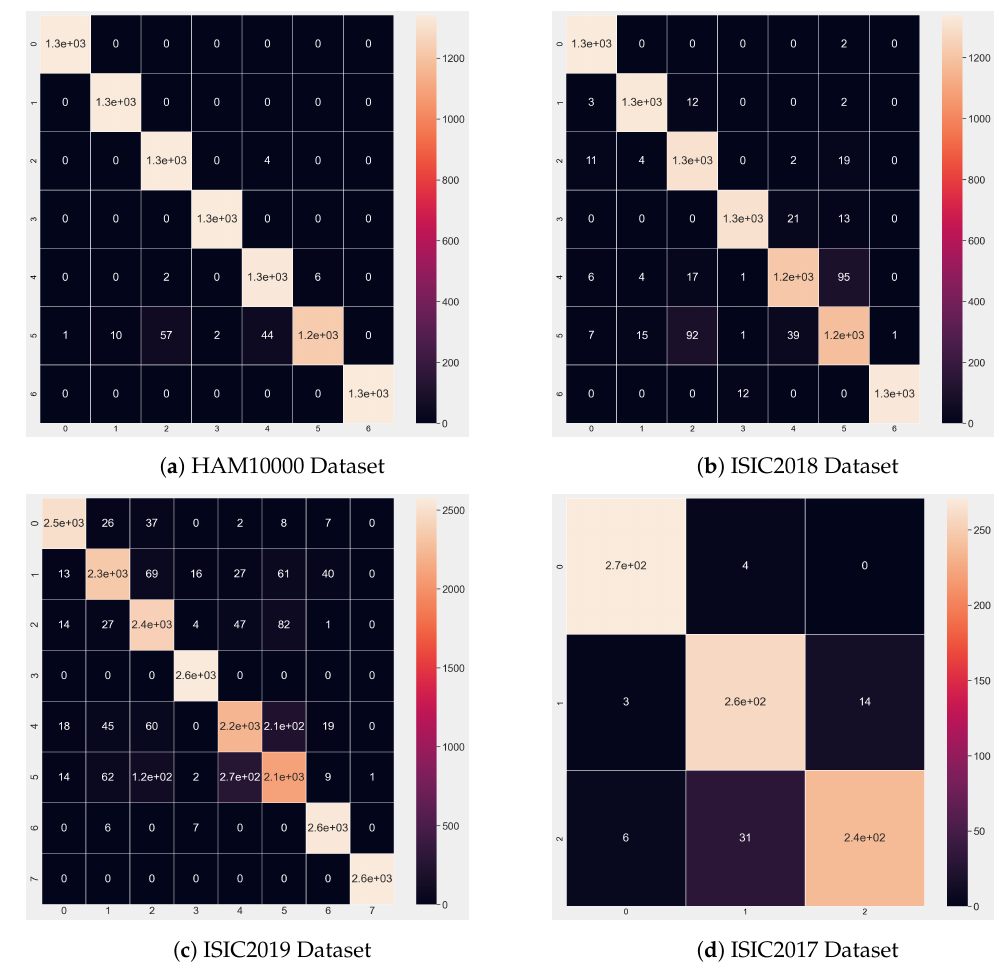
Figure 8. The Confusion Matrices for the HAM10000, ISIC2018 and ISIC2019 datasets, respectively.